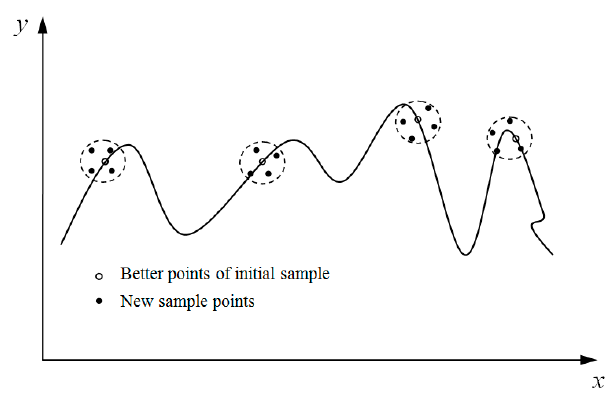
Figure 8. Adaptive sampling point adding strategy.